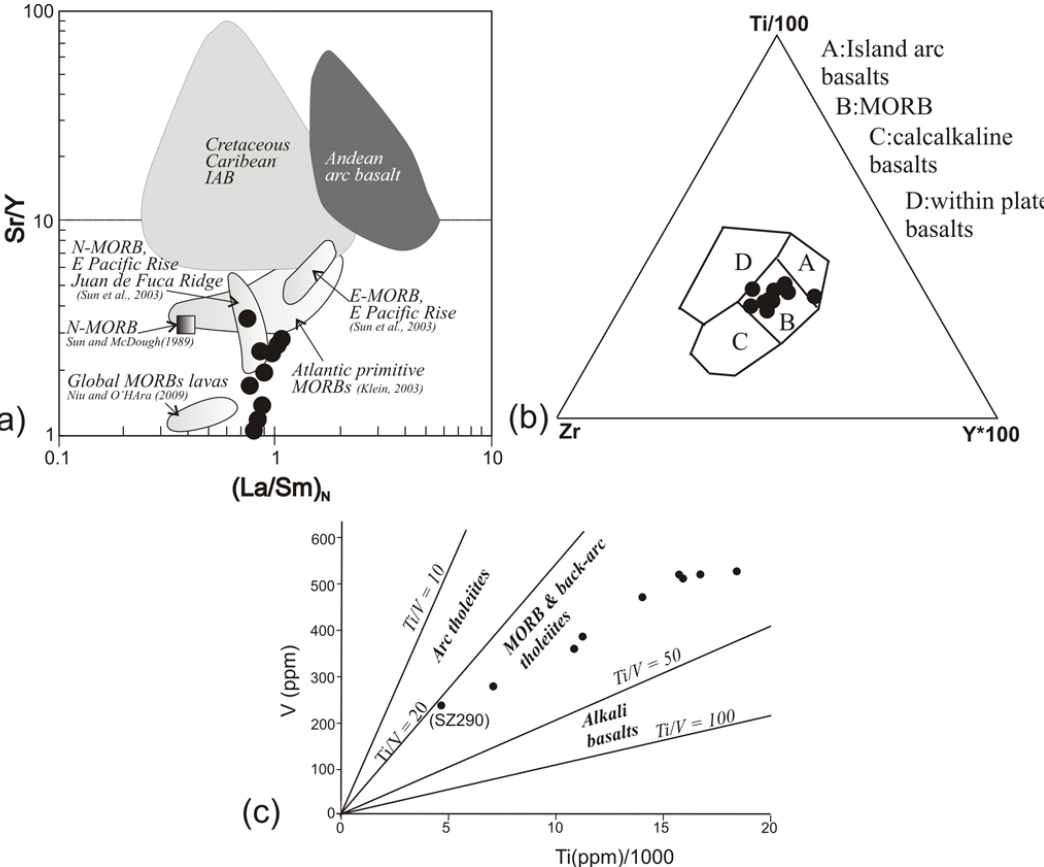
Fig. 7. Geotectonic discrimination diagrams for the Sabzevar granulites. (a) Sr/Y vs. (La/Sm) N diagram (modified after Berger et al., 2009 and references therein). (b) After Pearce and Cann (1973); (c) after Shervais